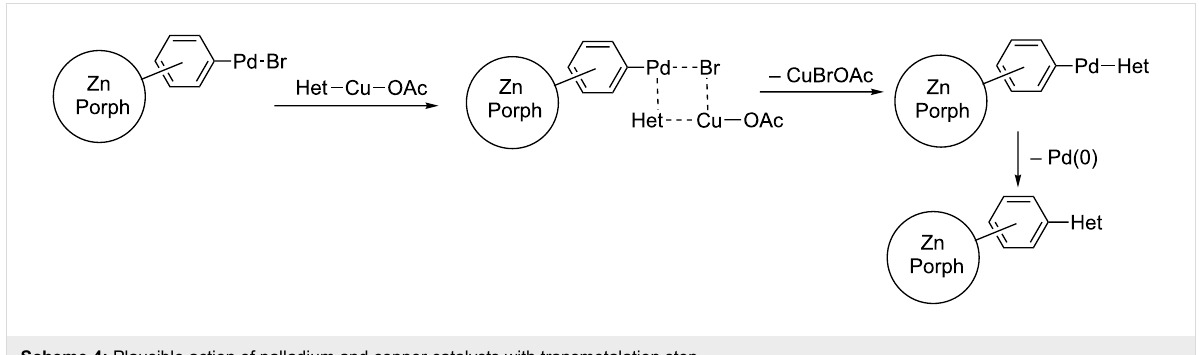
Scheme 4: Plausible action of palladium and copper catalysts with transmetalation